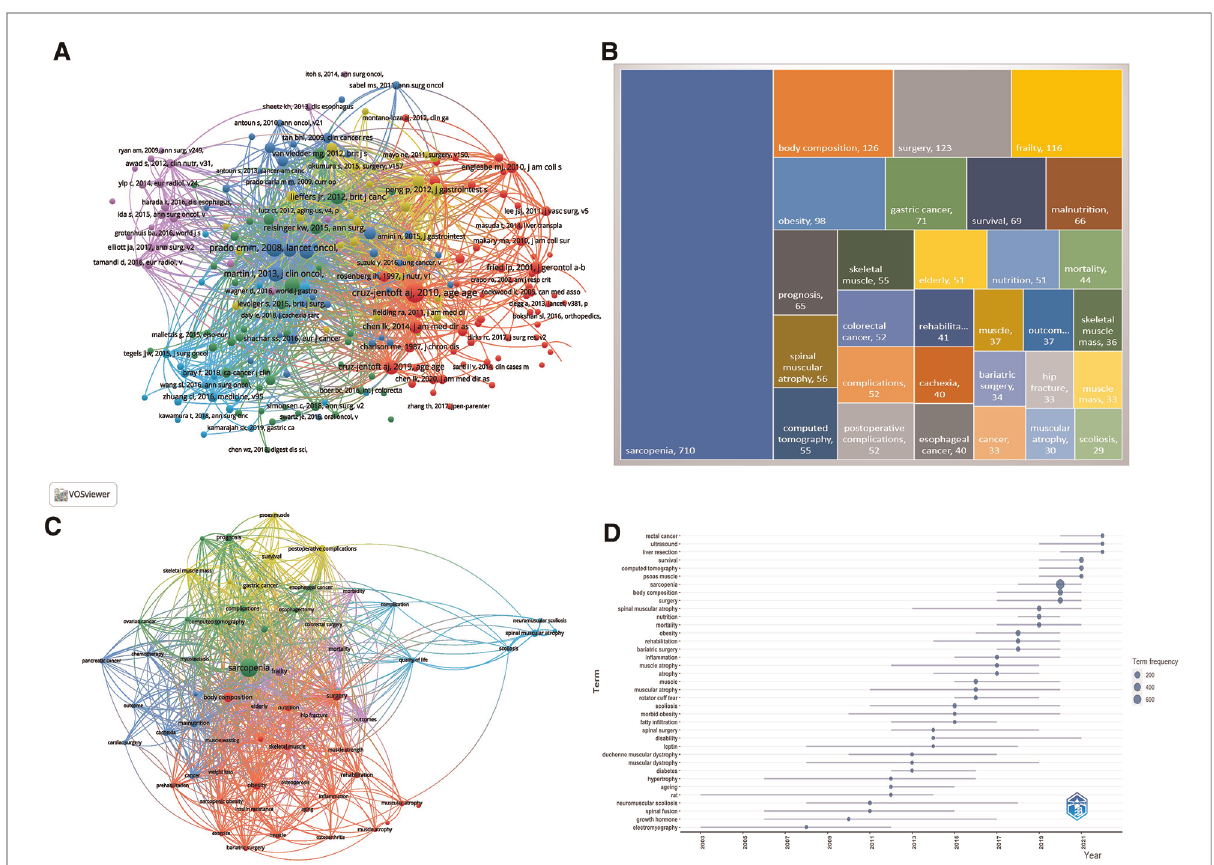
FIGURE 4 Information of the co-cited publications and keywords: ( A ) Map of the co-cited relationships of publications: the size of nodes represents the number of co-cited times and the line means their co-cited relationship; ( B ) Distribution of the top 30 keywords; ( C ) The map of clusters of keywords: the size of nodes represents the number of co-occurrence times and the line means their co-occurrence relationship. Different color means different clusters; ( D ) The map of keywords and their occurrence